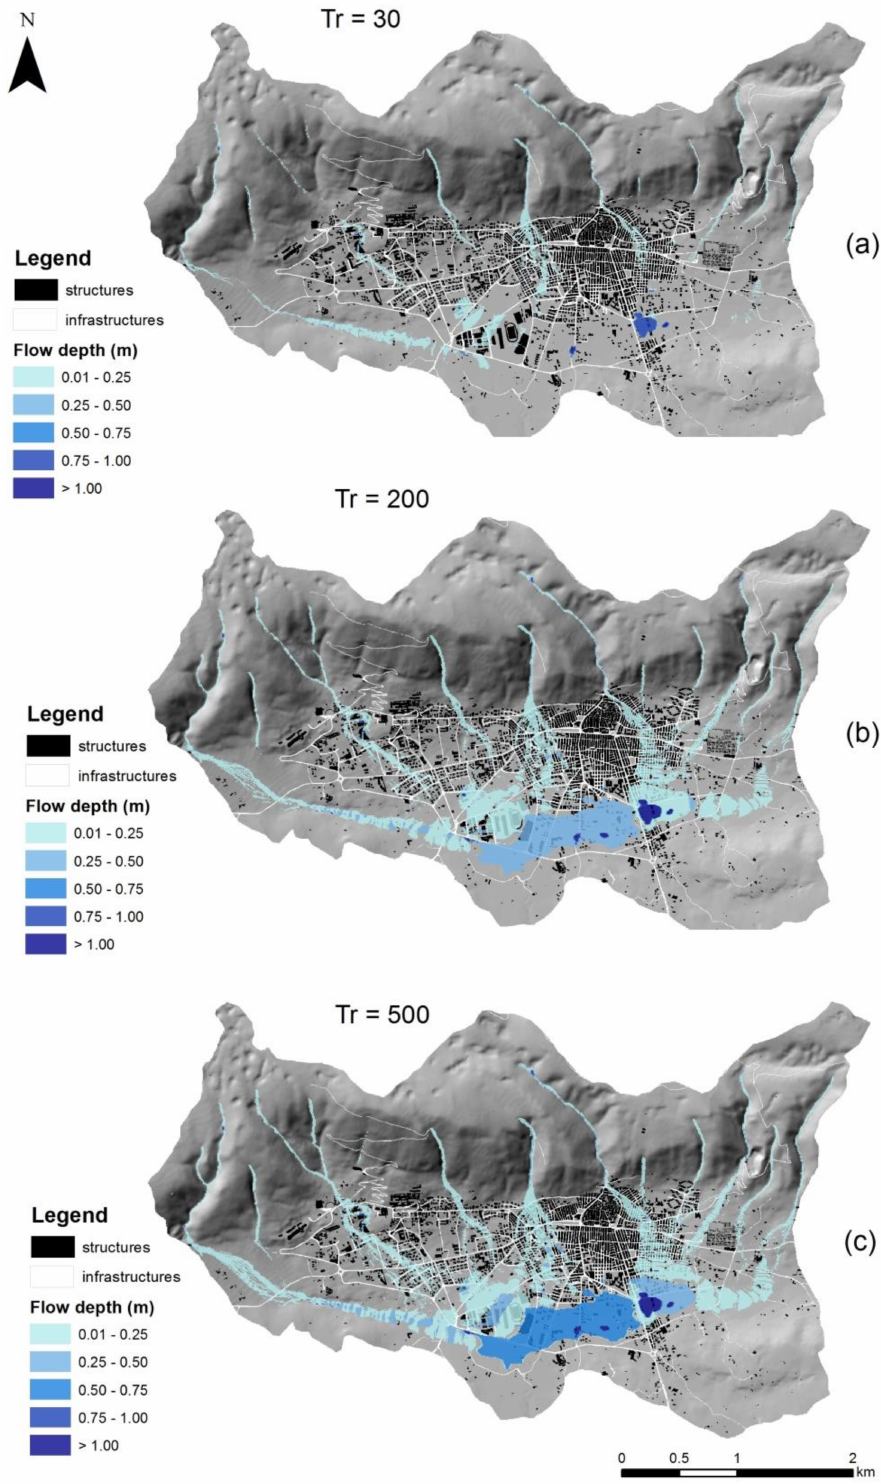
Figure 6. Flooding areas for the three hazard scenarios with return period of 30 ( a ), 200 ( b ) and 500 ( c )